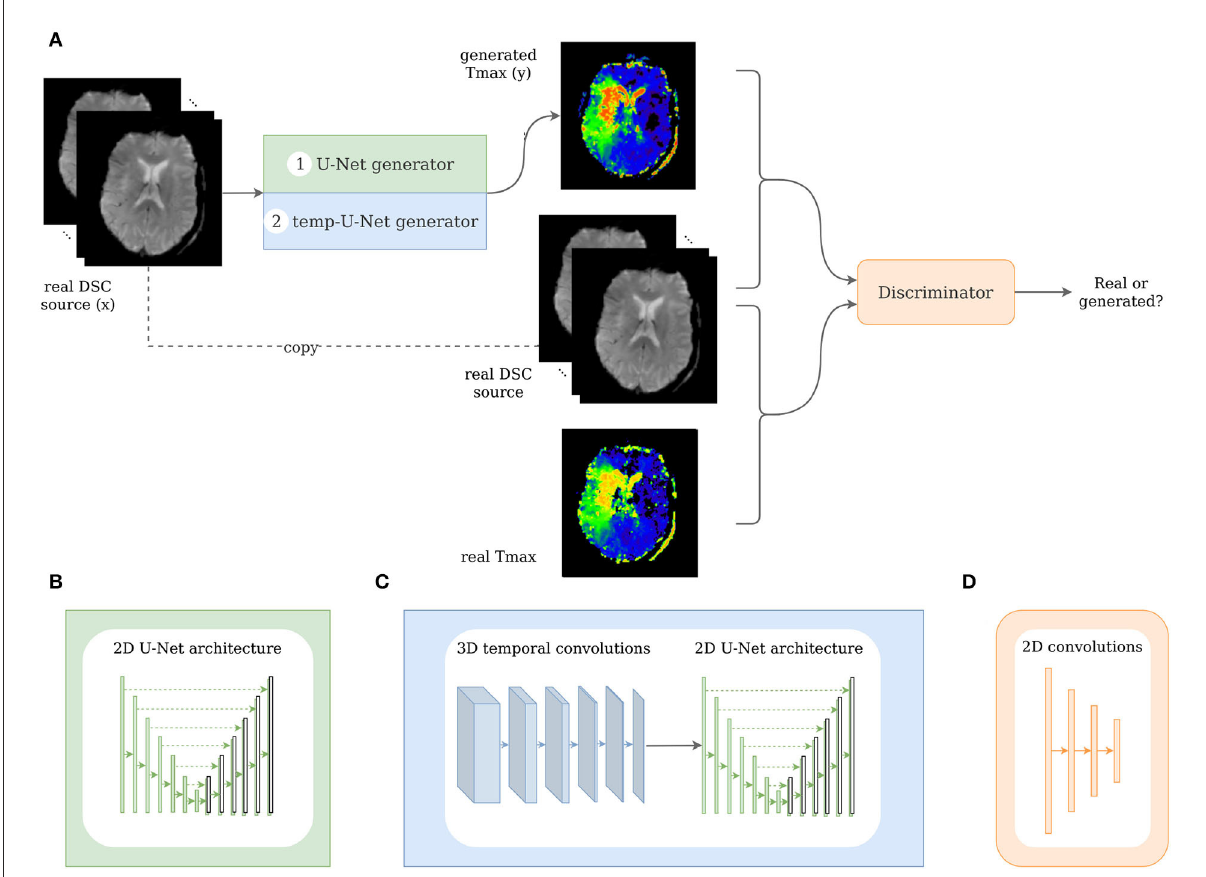
FIGURE3 Architecture of the pix2pix and temp-pix2pix GAN. (A) Shows the overall GAN architecture, whereas (B, C) depict the two different generators, and (D) shows the discriminator.